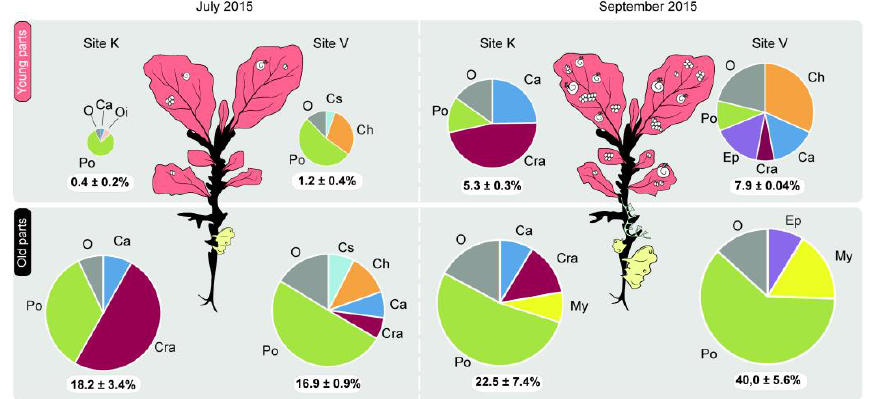
Figure 1. Dominant species composition (on piecharts) and average total cover (in white boxes) of epibiosis on young and old plant parts of Phycodrys rubens in July and September 2015. Piechart diameter denoteslog total percent covers(framespooled). Po—Porifera, My—juvenileMytilidae ( Musculusdiscors and Modiolus modiolus ) (Bivalvia). Ch— Celleporella hyalina (Bryozoa), Cra— Cribrilina annulata (Bryozoa), Ep— Electra pilosa (Bryozoa). Ca— Circeis armoricana (Polychaeta). Cs— Calycella syringa (Hydrozoa), Oi— Orthopyxis integra (Hydrozoa), O—all other